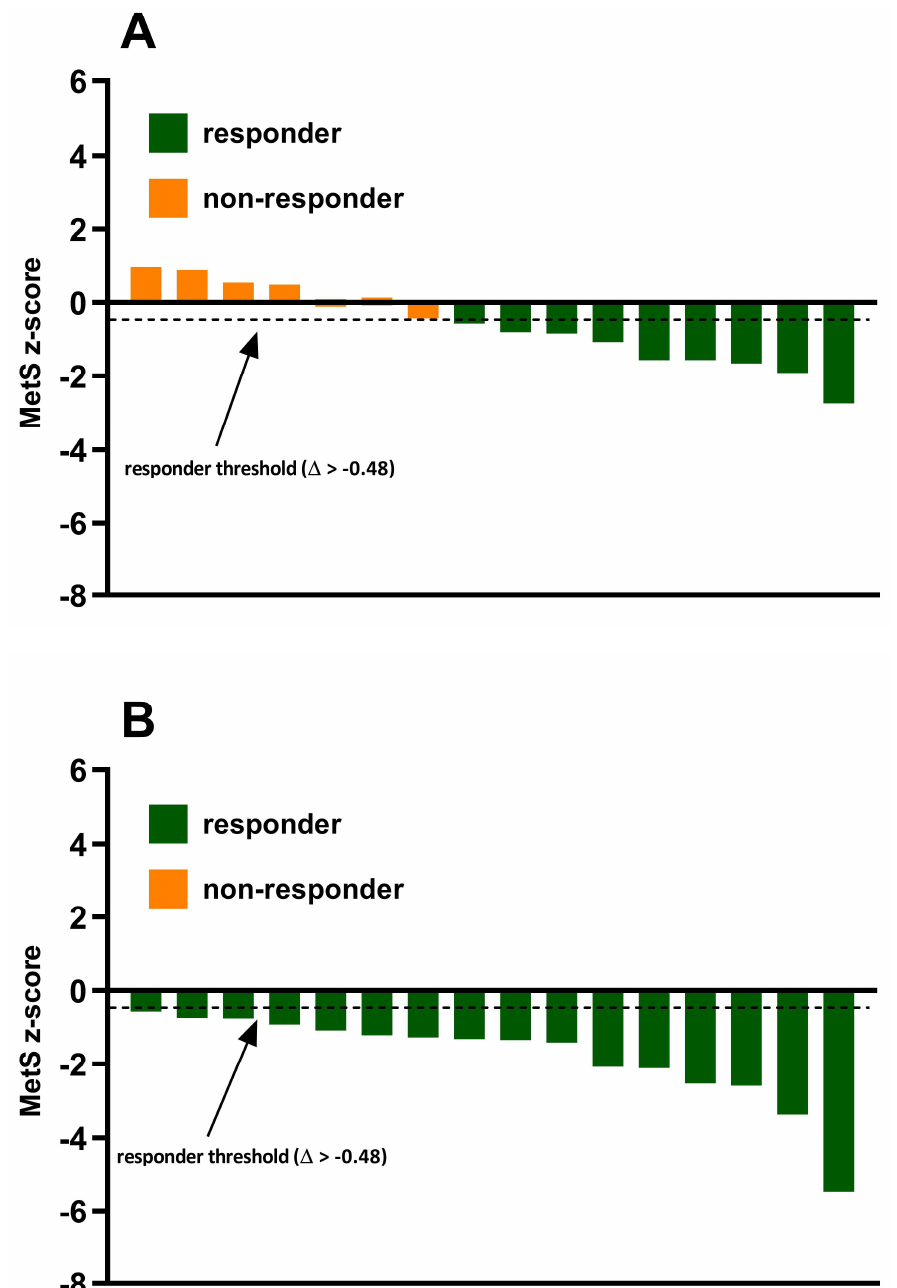
Figure 3. Inter-individual variability in MetS z-score responses to exercise training in the ( A ) standardized MICT group and ( B ) personalized MICT + HIIT